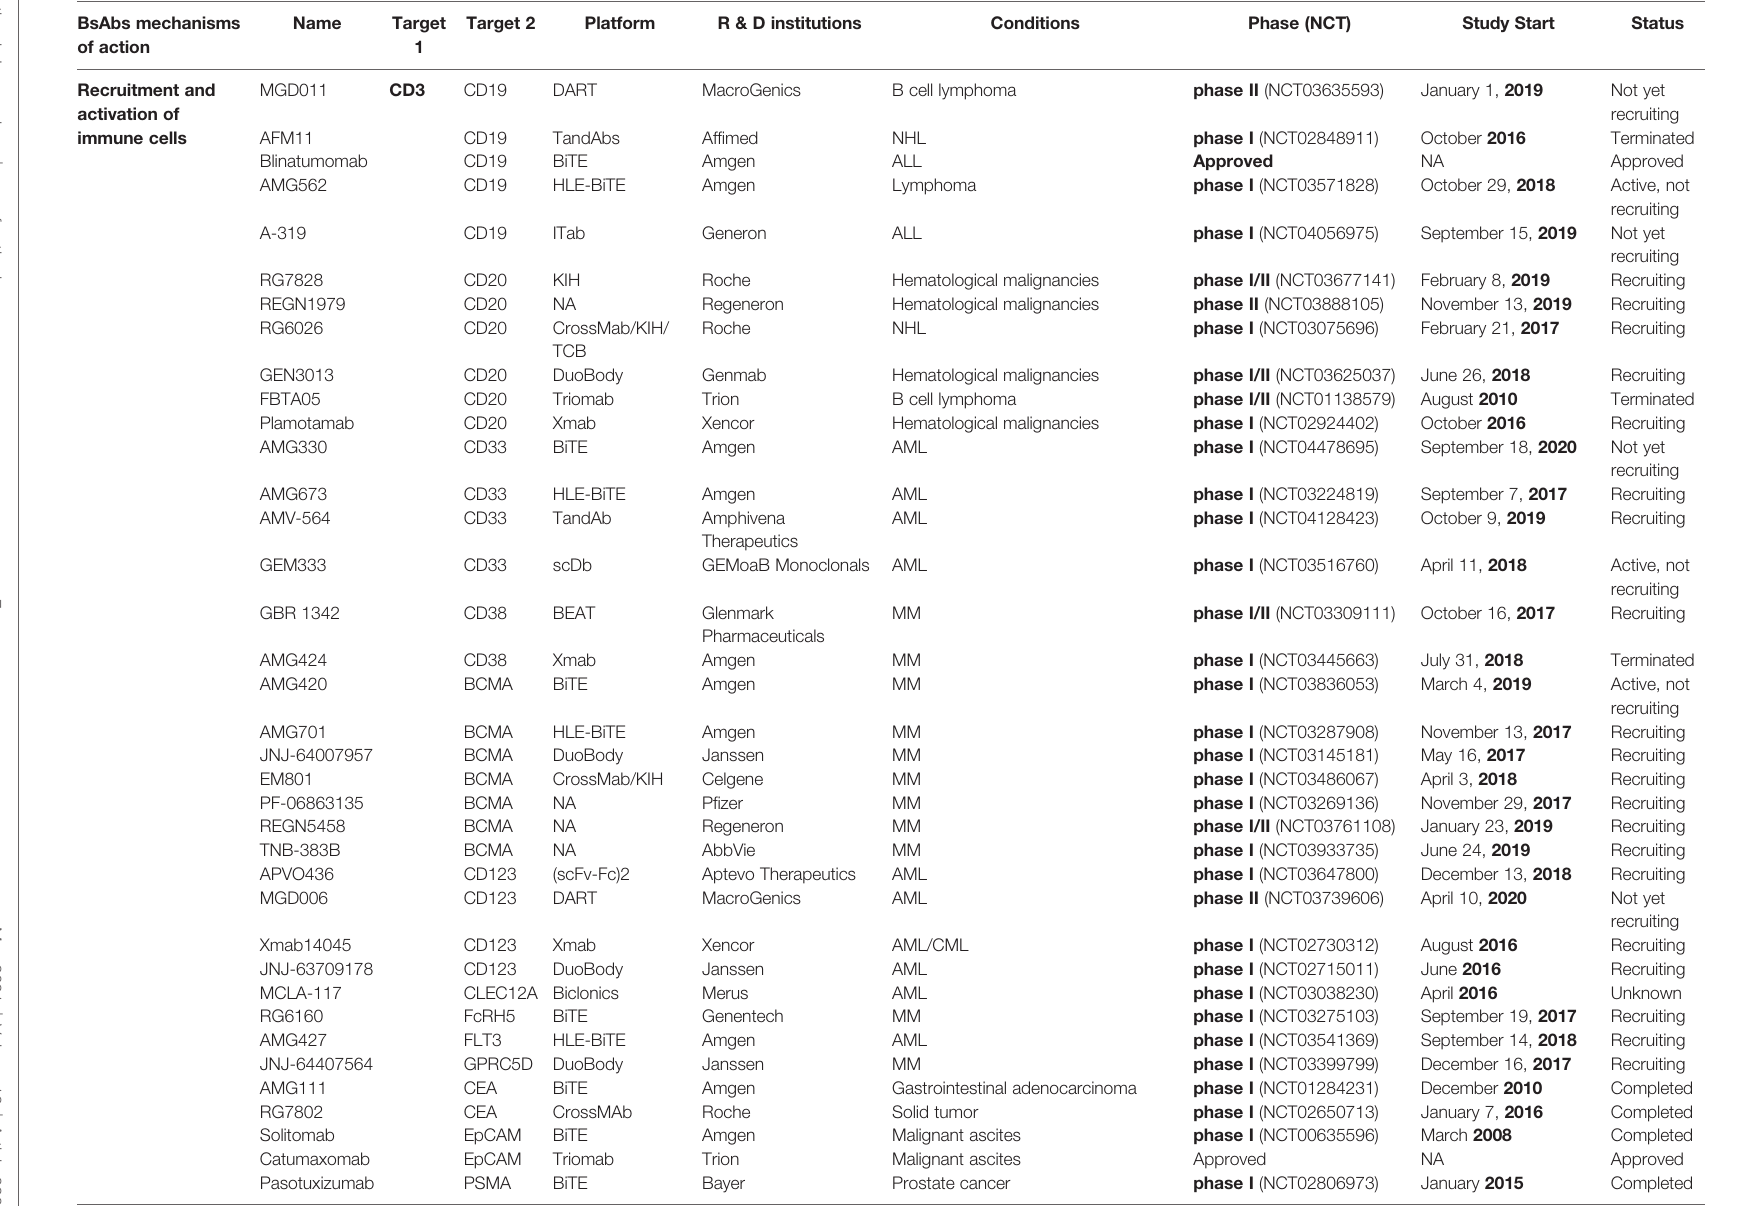
TABLE 1 | Summary of clinical BsAbs and their mechanisms of